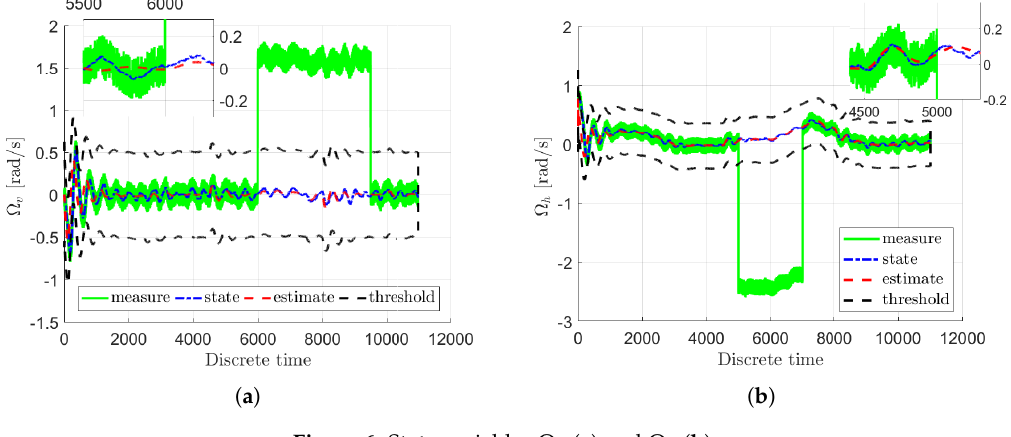
Figure 6. State variables Ω v ( a ) and Ω h ( b